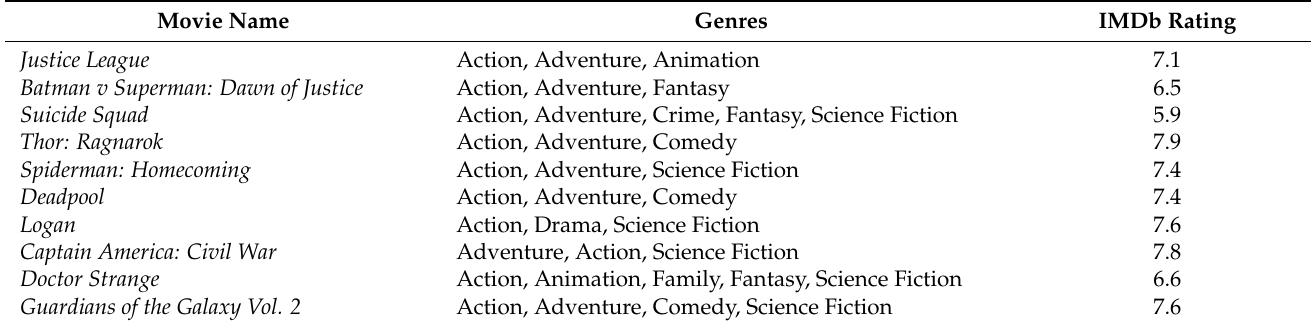
Table 17. Recommended movies for the movie Wonder Woman according to IMDb.